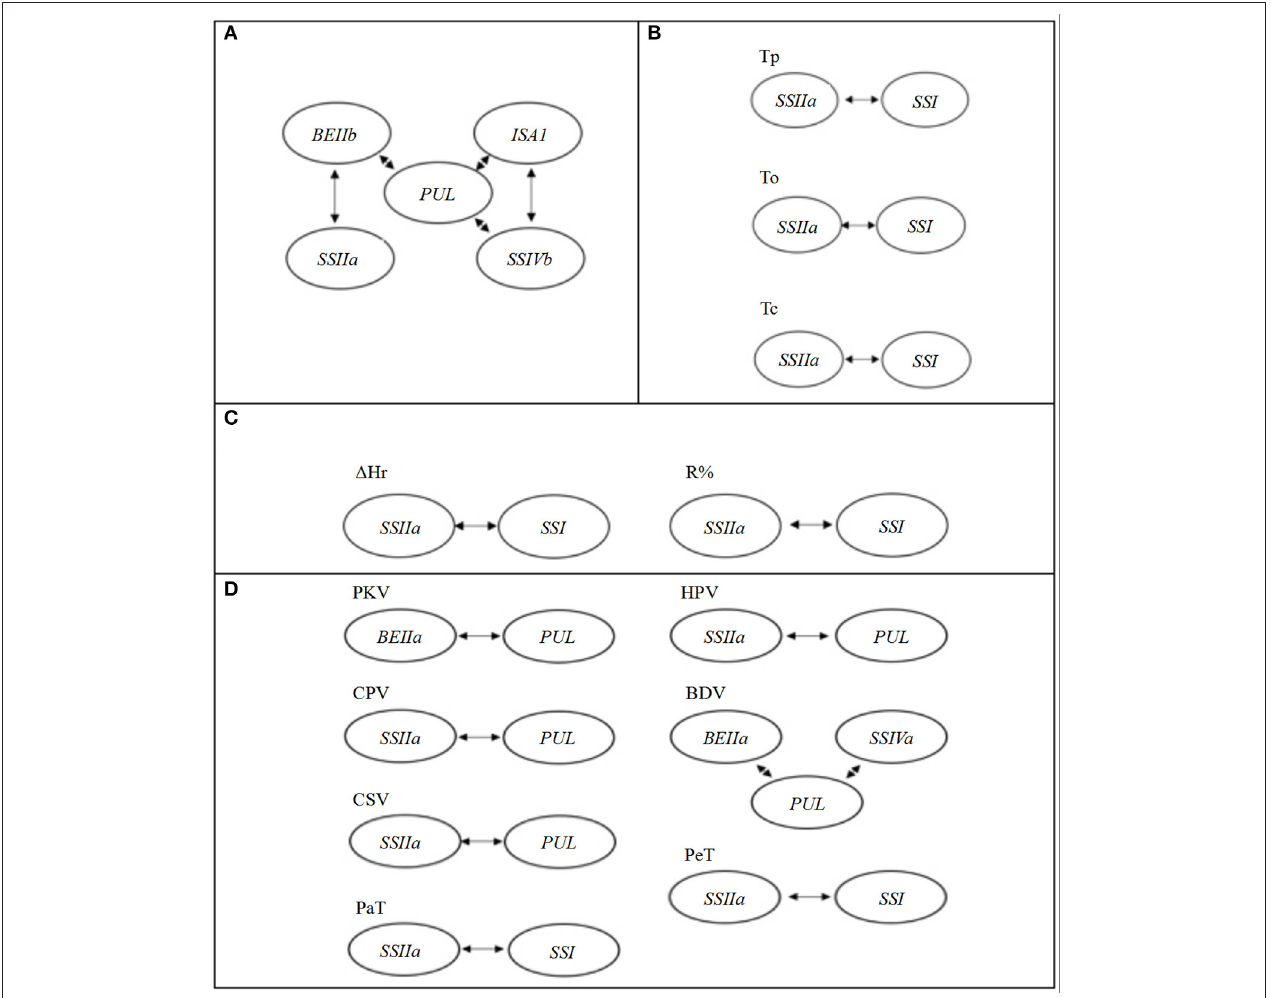
FIGURE 3 | The gene interaction effects for different quality traits. (A) The starch gel consistency (GC); (B) the starch thermal properties; (C) the starch RP; (D) the starch pasting viscosity